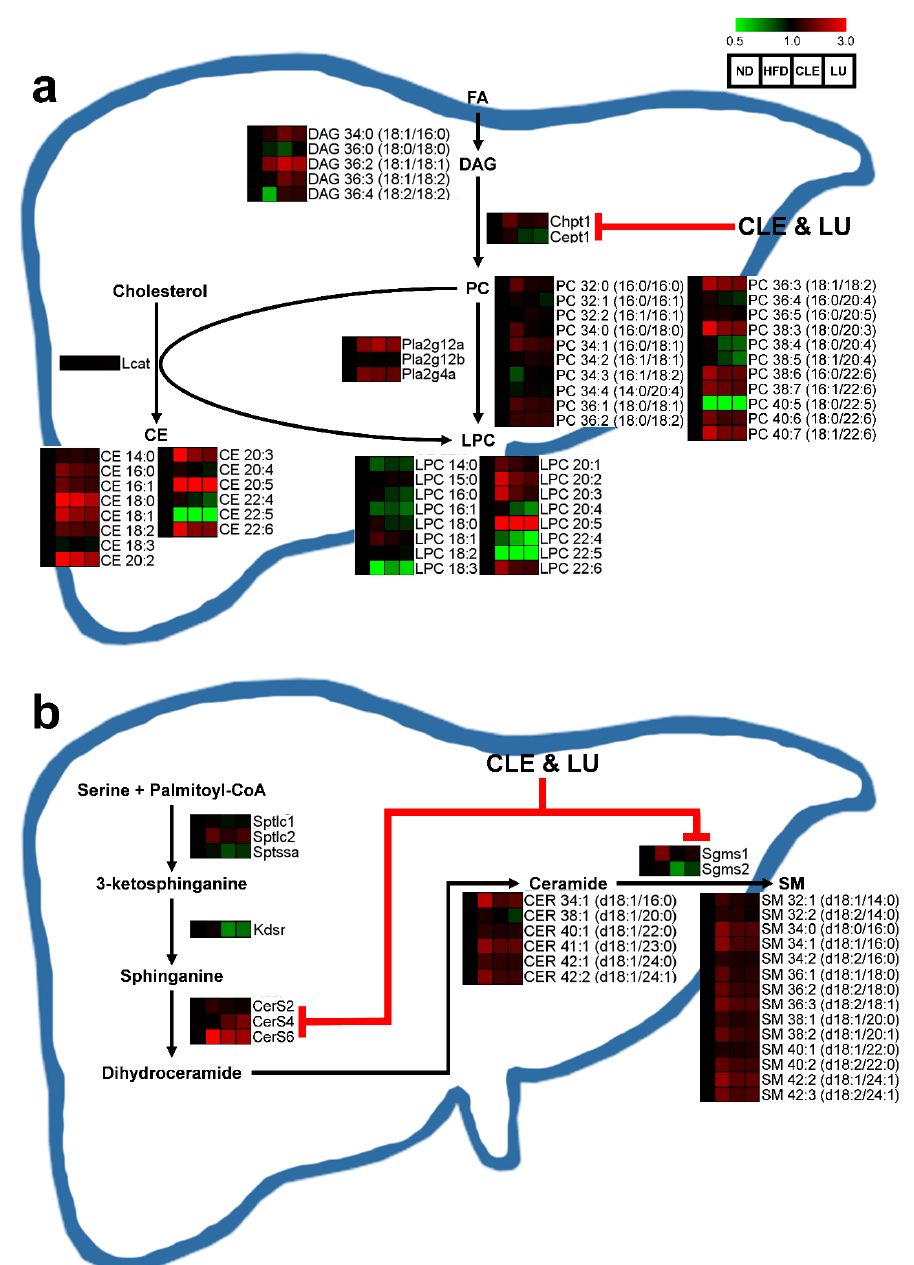
Figure 5. Scheme of the phospholipid synthesis ( a ) and sphingolipid synthesis ( b ) by which Chrysanthemum morifolium Ramat leaf extracts and luteolin regulates serum lipids and related hepatic gene-expression. The features of these compared to the ND group are color-coded by row, with red indicating high levels and green indicating low levels. ND: normal diet; HFD: high-fat diet; CLE: HFD plus Chrysanthemum morifolium Ramat leaf extract 1.5% diet; LU: HFD plus luteolin 0.003% diet; FA: fatty acid; DAG: diacylglycerol; PC: phosphatidylcholine; LPC: lysophosphatidylcholine; CE: cholesteryl ester; CER: ceramide; SM: sphingomyelin. CER, a precursor and major molecule of sphingolipids, and SM, which may act as a pool for the generation of CER, are the most abundant sphingolipids in lipoproteins and constitute about 3% and 87% of plasma sphingolipids, respectively [55]. Similar to our study, several studies have reported